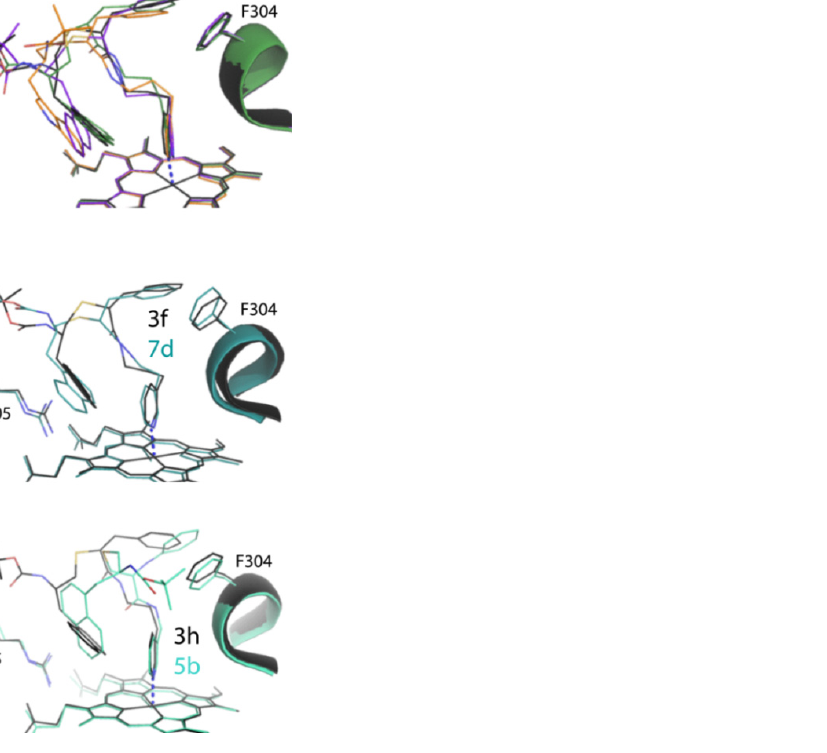
Figure 7. ( A ) Structural overlay of the 3e – i -bound complexes. Unlike 3b ( S , R ) (Figure 4A), 3f ( S , R ) binds in a traditional orientation. However, 3f forms the longest Fe–N bond and cannot establish an H-bond with the active site S119 (Table 2), meaning that the R/S configuration is still less favourable. ( B ) Superposition of isosteric 7d (series IV analogue [10]) and 3f shows a small impact of one-atom linker elongation on the ligand binding mode. ( C ) Comparison of the best series IV and V inhibitors, 5b [10] and 3h . The pyridyl–ethyl containing 5b has a five- rather than four-atom R 1 –R 2 spacer (Figure 1B) and adopts a distinct conformation in the active site: R 1 –phenyl protrudes deeper into the P1 pocket, R 2 -naphthalene is perpendicular rather than parallel to the heme, and the terminal Boc-group points away rather than toward the substrate